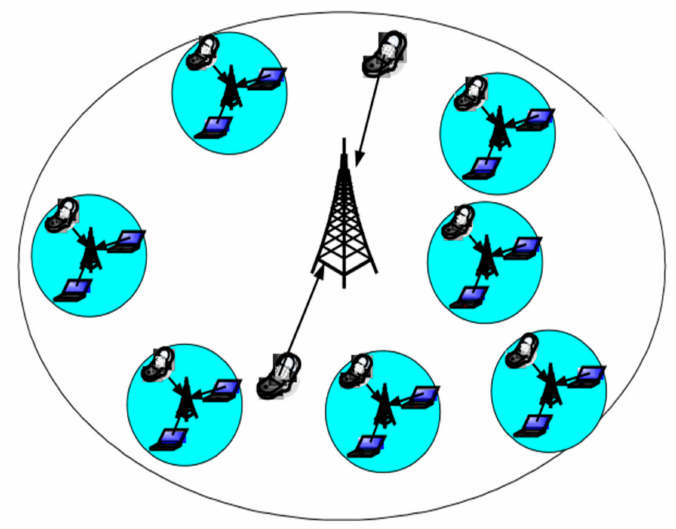
Figure 5. Microcells installed cell towers, which improve coverage in environments with limited signal